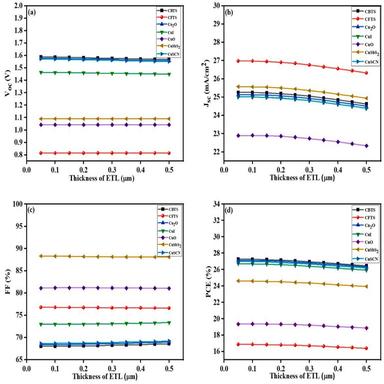
Thickness of ETL ZnSe versus SC performance parameters.